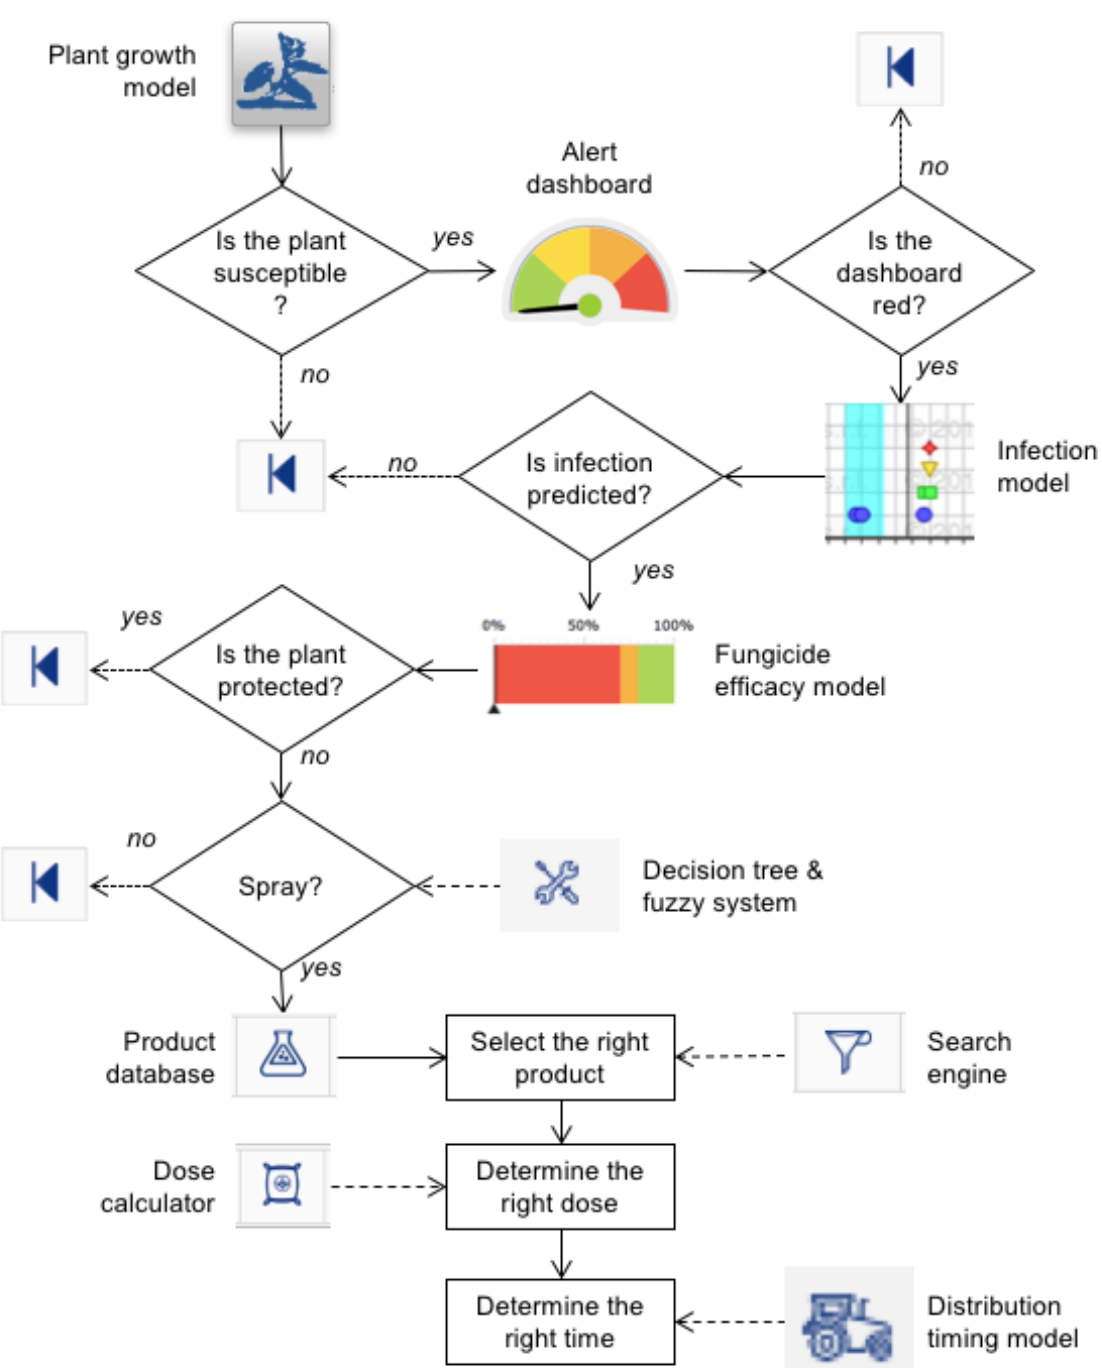
Figure 8. Scheme of how a farmer navigates within the DSS vite.net ® , in order to decide whether a fungicide spray is re- quired, and when it should be applied if it is required, based on plant growth, infection risk, and the protection provided by any previous fungicide application. If the user decides to apply fungicide, the DSS helps the user select the best product (based on multiple selection criteria including active ingredient, mode of action and activity) and, given that product, the correct application dosage and application time during the